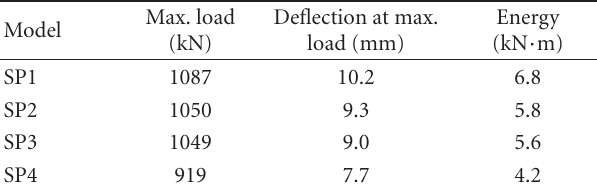
Table 3: Summary results for finite element models with spatially distributed, local maximum cross-sectional loss in